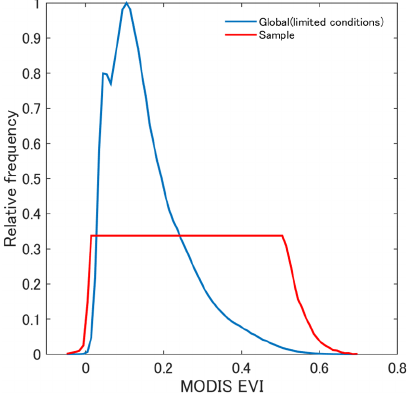
Figure 2. Relative frequency of MODIS EVI extracted from the climate modeling grid (CMG) data with the limited conditions regarding view zenith and azimuth angles and time period, denoted by blue line and that of data used for optimization (sample data), denoted by red line.